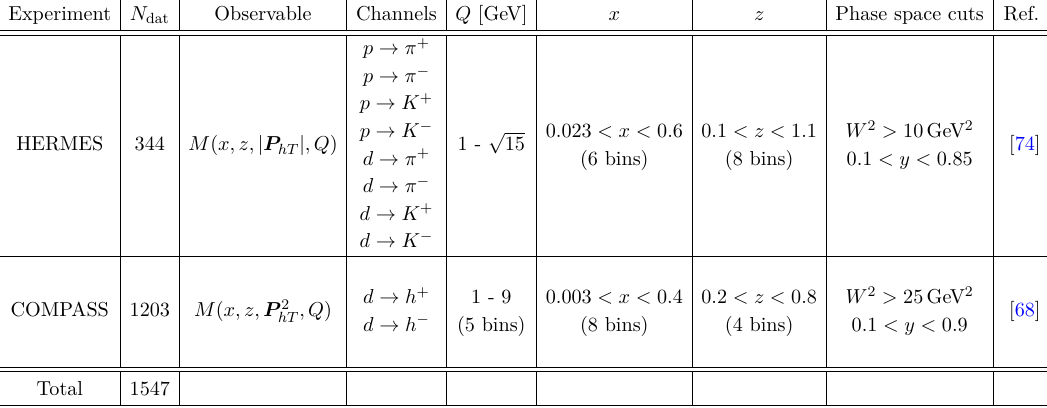
) surviving the nominal cut on , the P hT dat | |